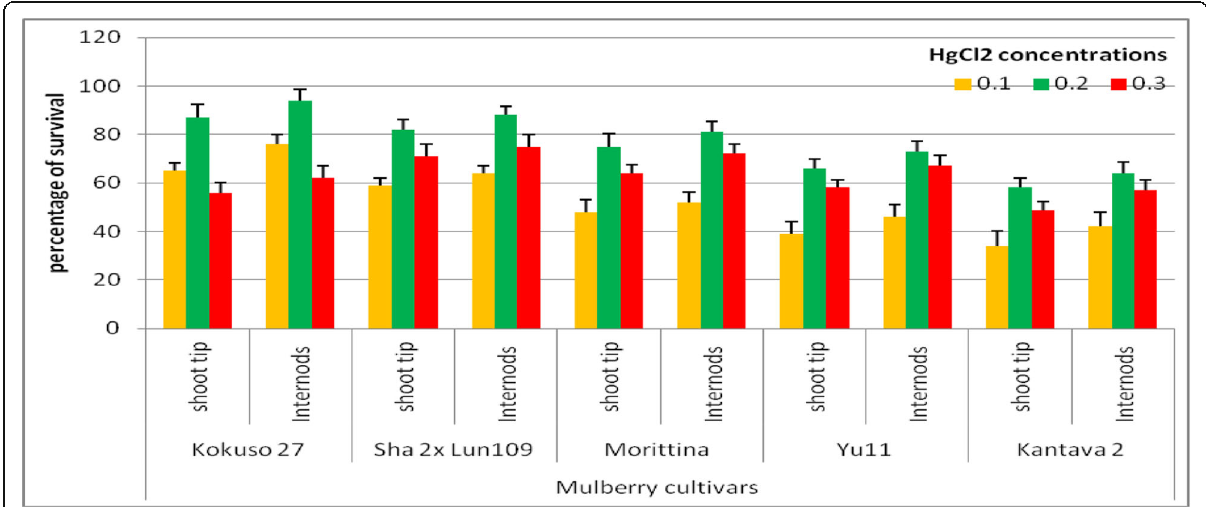
Fig. 2 Effect of sterilization treatments with HgCl2 (MC) at different concentrations (0.1, 0.2, and 0.3%) on the percentage of survival of explants in correlation with shoot development. Shoot tips and internodes of different mulberry cultivars were used as explants